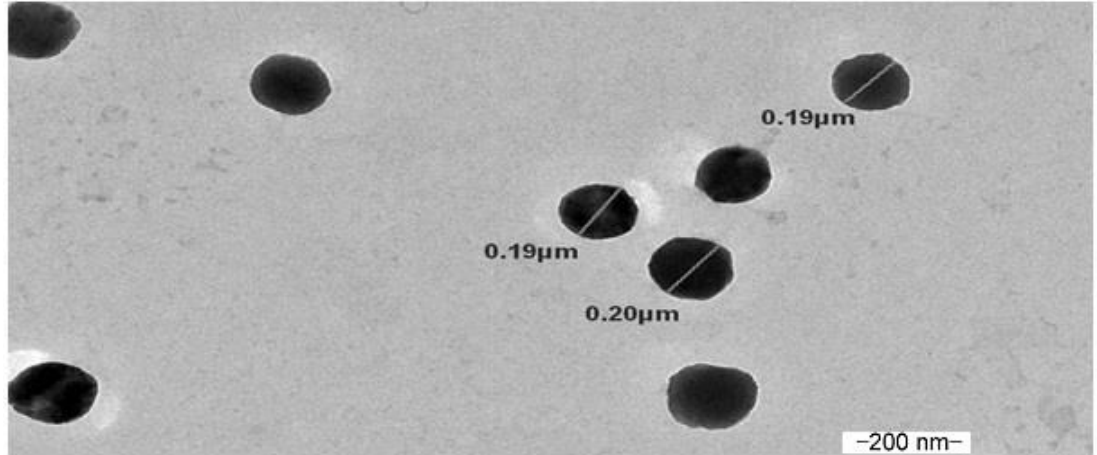
Figure 2. Transmission electron microscopy (TEM) image of MDZ-loaded CS NPs containing 1 CS and 1 mg / mL Na-TPP (Formulation F32 D1). mg/mL CS and 1 mg/mL Na-TPP (Formulation F32 D1).